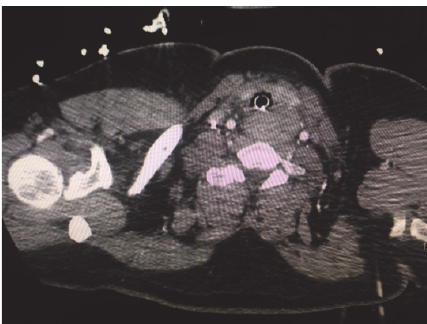
Figure1:Computerizedtomographyofchestdemonstratingforeign body impaction versus mass in